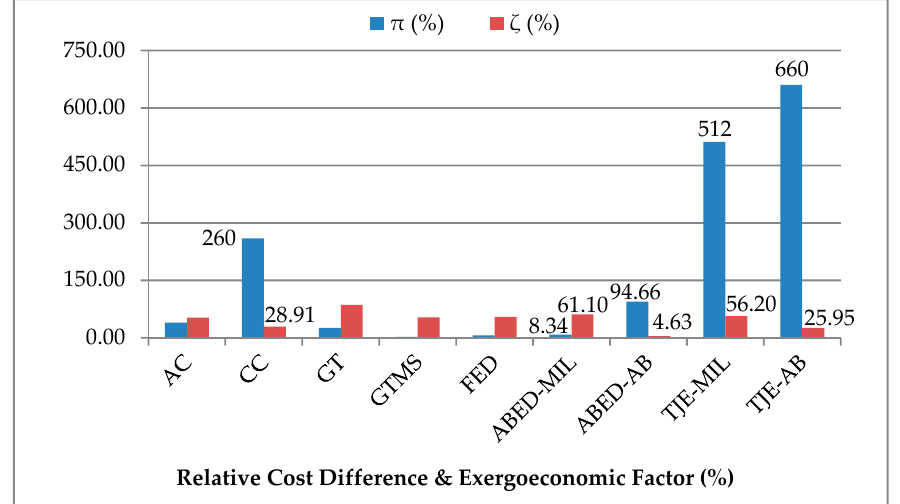
Figure 6. Relative cost difference ( π ) and exergoeconomic factor ( ζ) with JP-8 fuel usage.